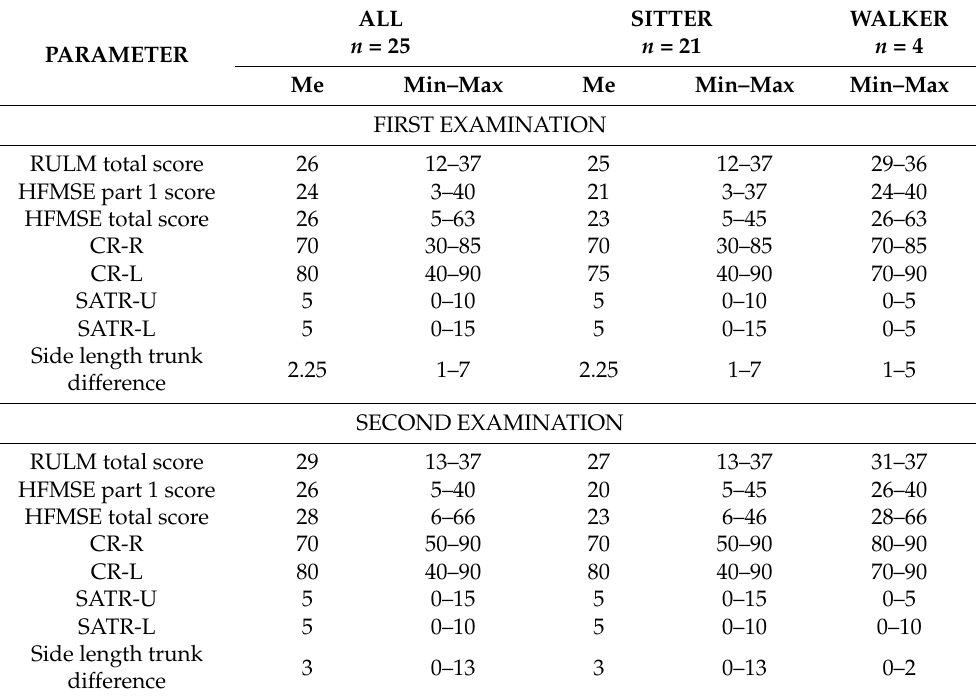
Table 2. Results from the functional scales and structural parameters during the first and second examination.